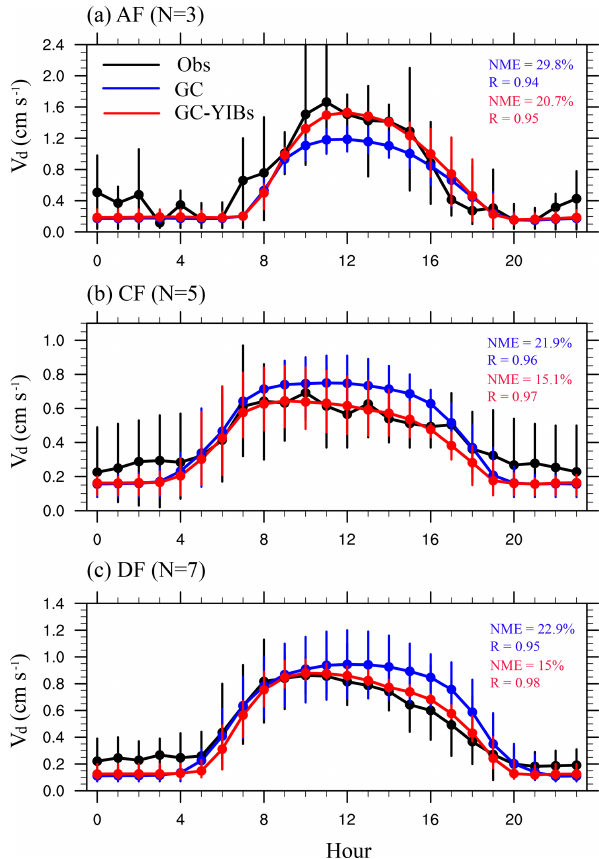
Figure 9. Comparison of multi-site mean diurnal cycle of O 3 dry deposition velocity at the Amazon (a) , coniferous (b) , and decidu- ous (c) forests. Error bars represent the range of values from differ- ent sites. Black lines represent observed O 3 dry deposition velocity. The blue and red lines represent simulated O 3 dry deposition veloc- ity by GC (Offline simulation) and online GC-YIBs (Online_ALL simulation) models, respectively. The site number ( N ), R , and NME are shown for each